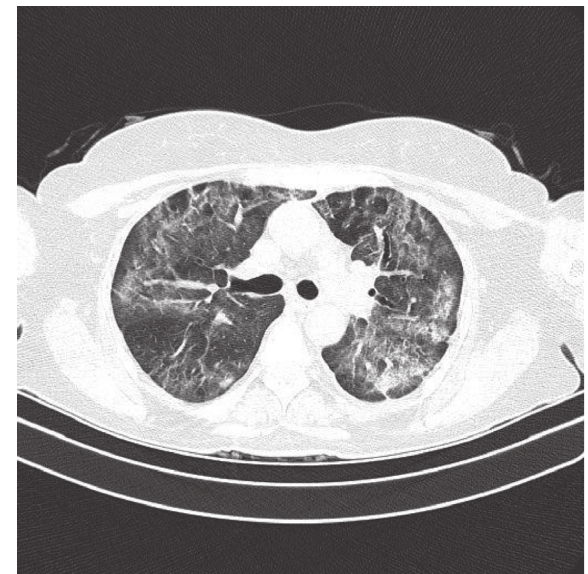
Figure 2: Control CT image shows partial absorption of the or- ganizing consolidations and architectural distortion with the for- mation of fibrous